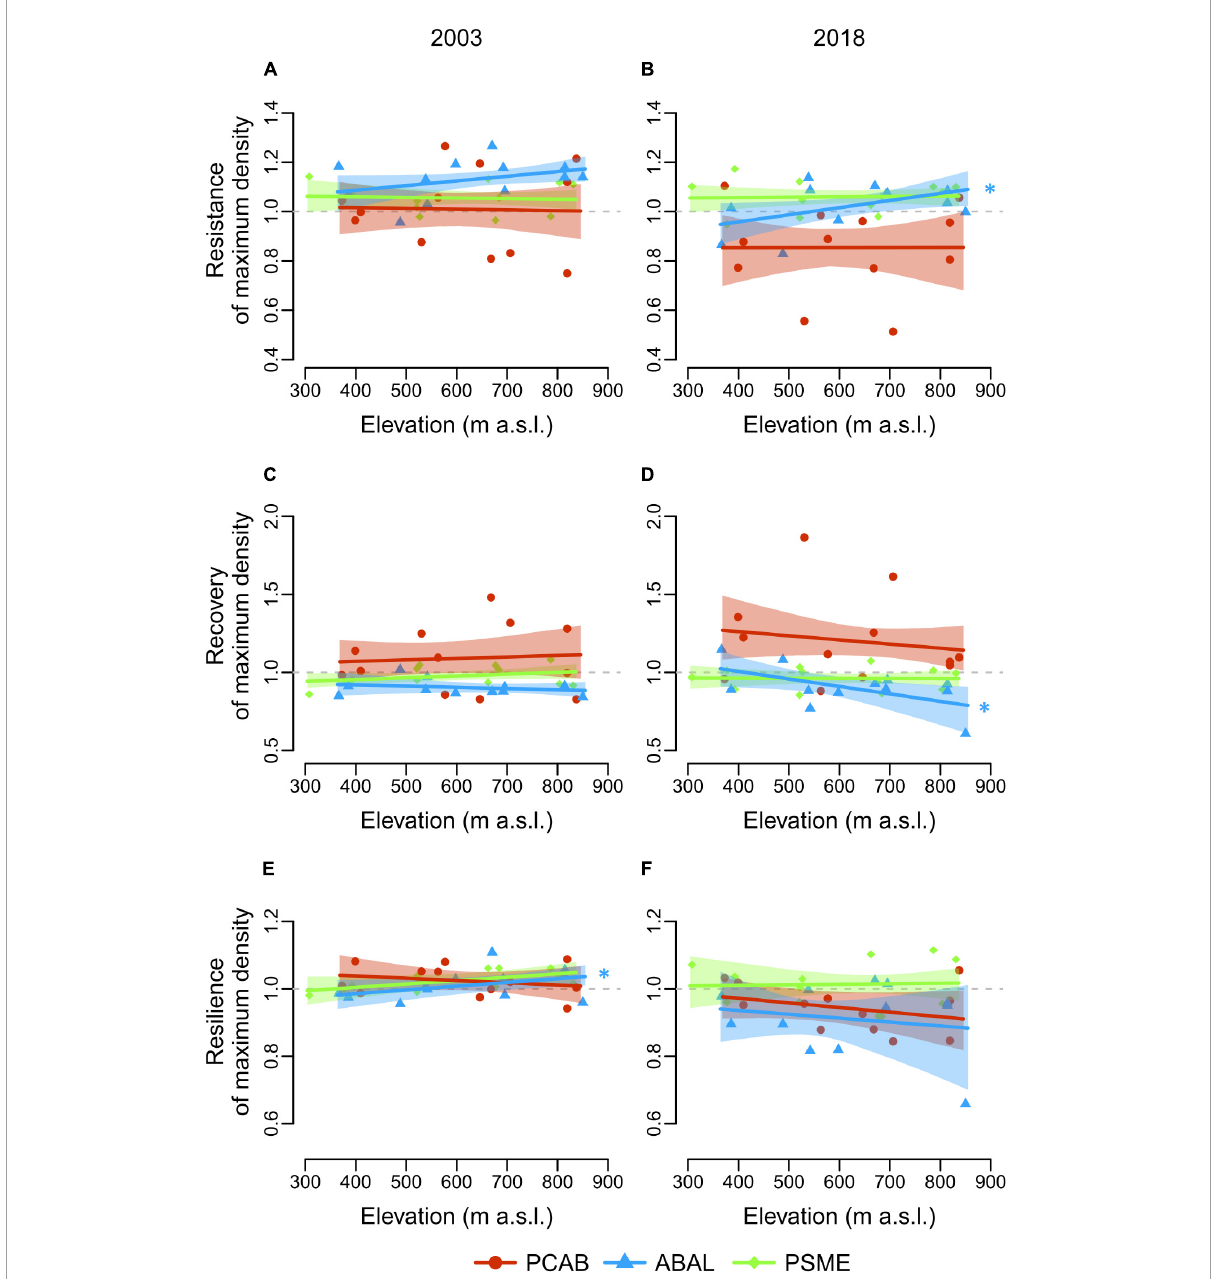
FIGURE5 Resistance (A,B) , recovery (C,D) and resilience (E,F) indices of maximum latewood density of Norway spruce (PCAB), silver fir (ABAL) and Douglas fir (PSME) in response to elevation for the two extreme drought events of the years 2003 (left) and 2018 (right). Transparent ribbons indicate bootstrapped 95 % confidence intervals of predictions of linear mixed-effects models based on 10,000 replications. For illustration, data points were averaged on the stand level. Asterisks on the right side of the panels indicate if slopes of the regression lines are significantly different from zero based on bootstrapped confidence intervals: 95% “*”, 99% “**”, 99.9% “***”. Marginal R 2 and conditional R 2 of the linear mixed-effects models are listed in Supplementary Table 3